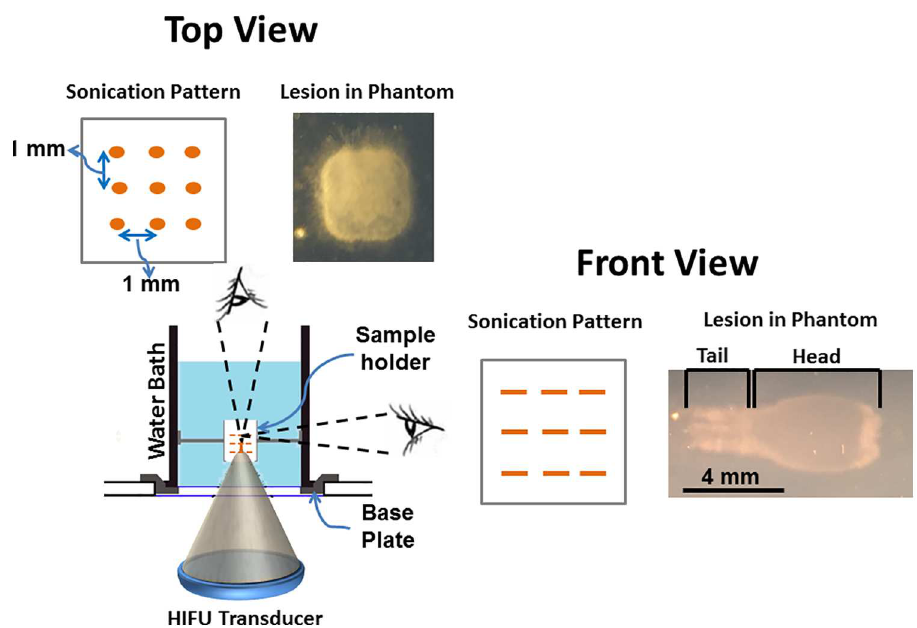
Fig 1. Diagram showing the experimental setup used to produce BH lesions on a clinical MR-HIFU systemin both tissue-mimicking phantom and ex vivo tissue. The setup consists of a water bath, filled with degassedwater. This water bath was placed on an acousticallyhypoehoic membrane. This membrane made it possiblefor the HIFU beam to pass through and into the water bath. The sonicationpattern is a 3 × 3 × 3 cube with 1 mm spacingbetweeneach point in either direction. The lesionin top-view, looks like a square, and appears‘tad-pole’shaped in any plane parallelto the HIFU beam.